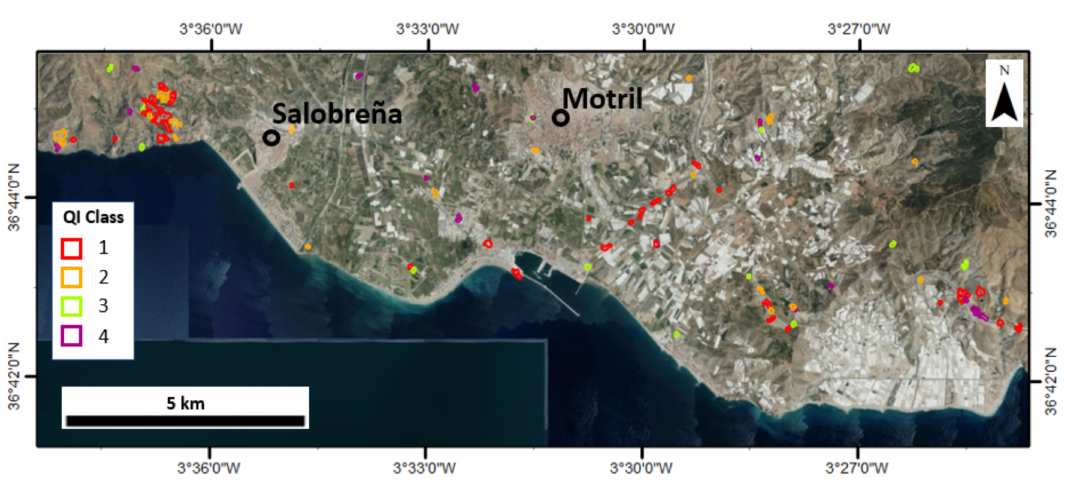
Figure 2. An example of the output of ADAfinder in the coastal area of Granada (S Spain). Colors are used to show the quality of the time series (TS) information according to the quality index attribute in the output shapefile. Red: “very reliable”, orange: “reliable”, lime-green: “not so reliable” and purple: “not